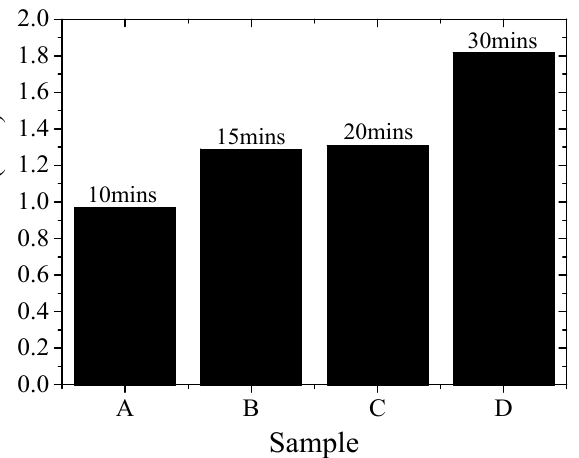
Figure 9. Deformation after machining.